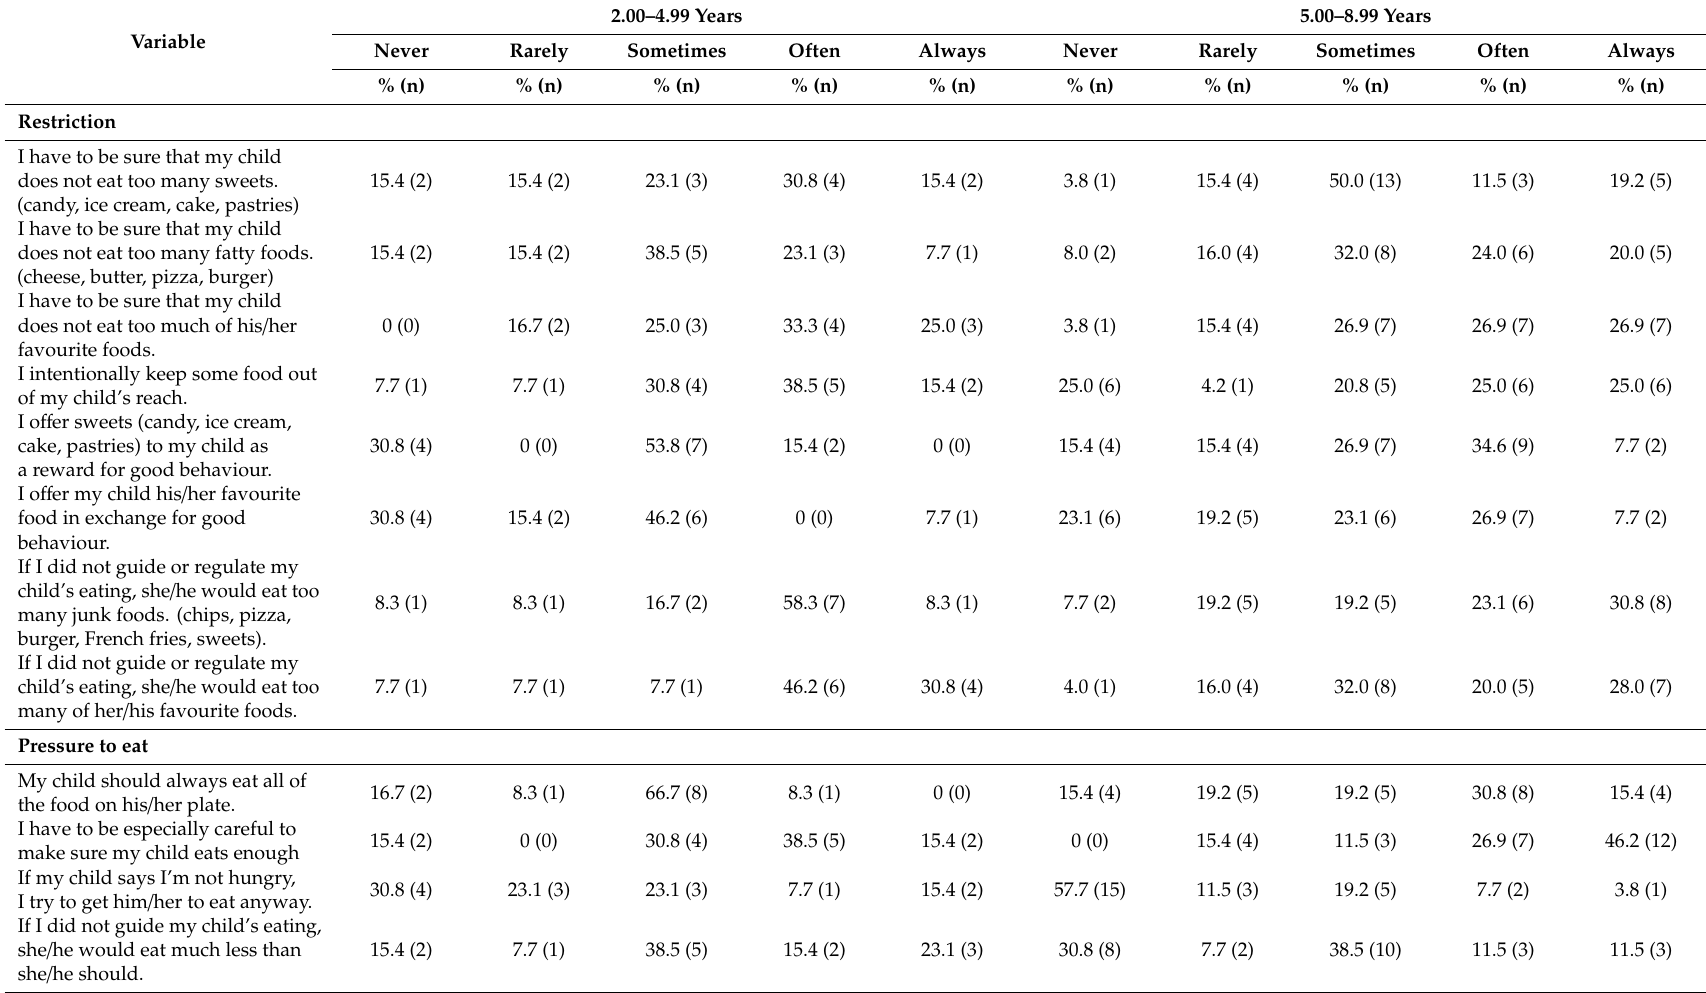
Table 8. Distribution of participants according to frequency of reported parent-child feeding relationship on Child Frequency Questionnaire (n = 82). Variable Never Rarely Sometimes Often Always Never Rarely Sometimes Often Always % (n) % (n) % (n) % (n) % (n) % (n) % (n) % (n) % (n) %